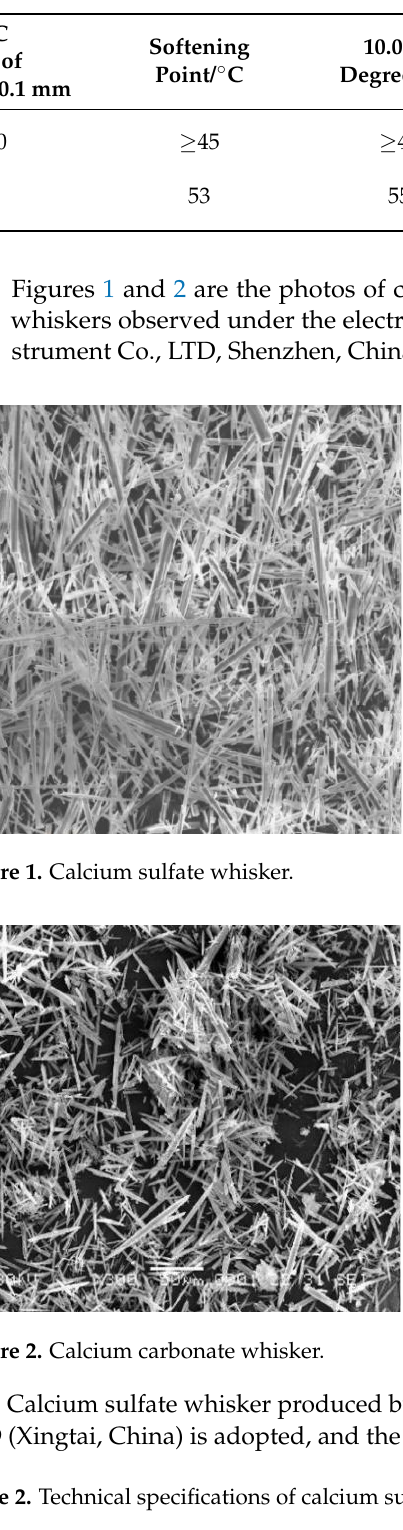
Table 1. Technical index and experimental data of 90# matrix asphalt.